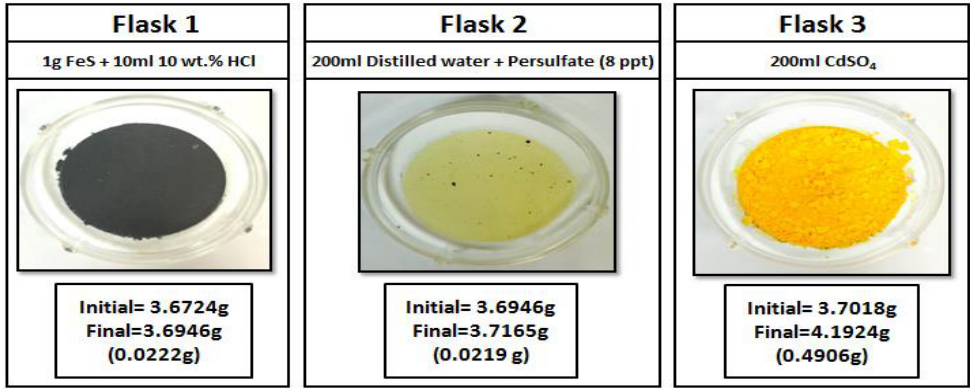
Figure 20. Persulfate gel breaker interactions in a sour environment for 4 h at 77 °F.